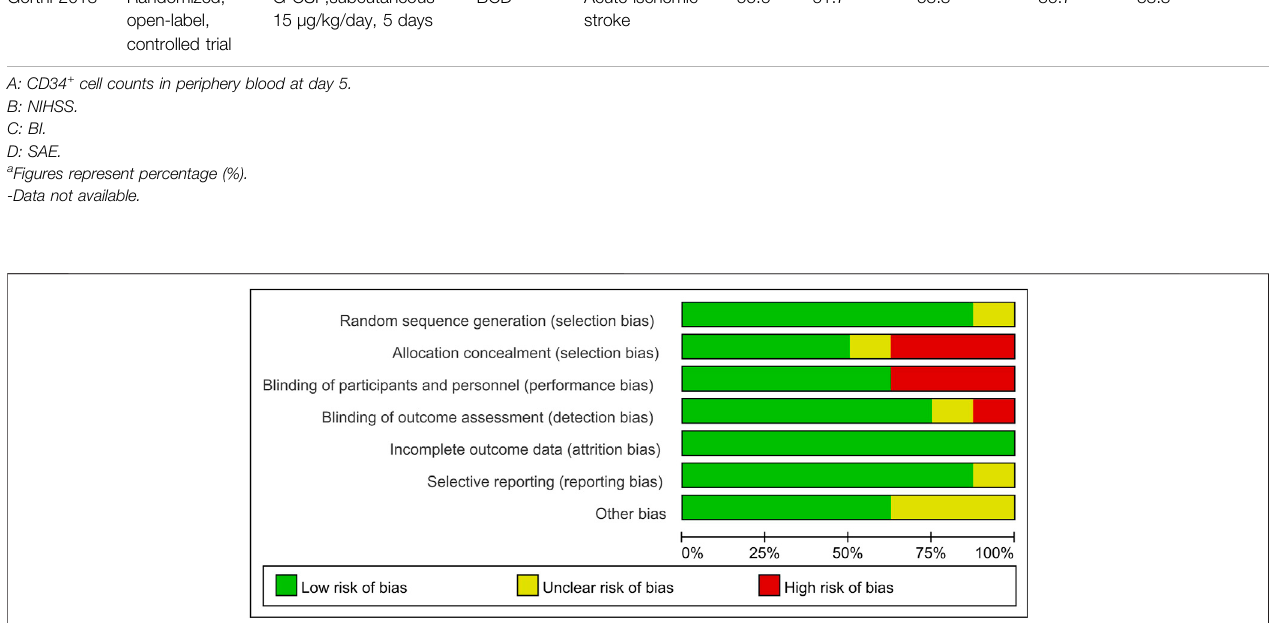
FIGURE 2 | Risk of bias